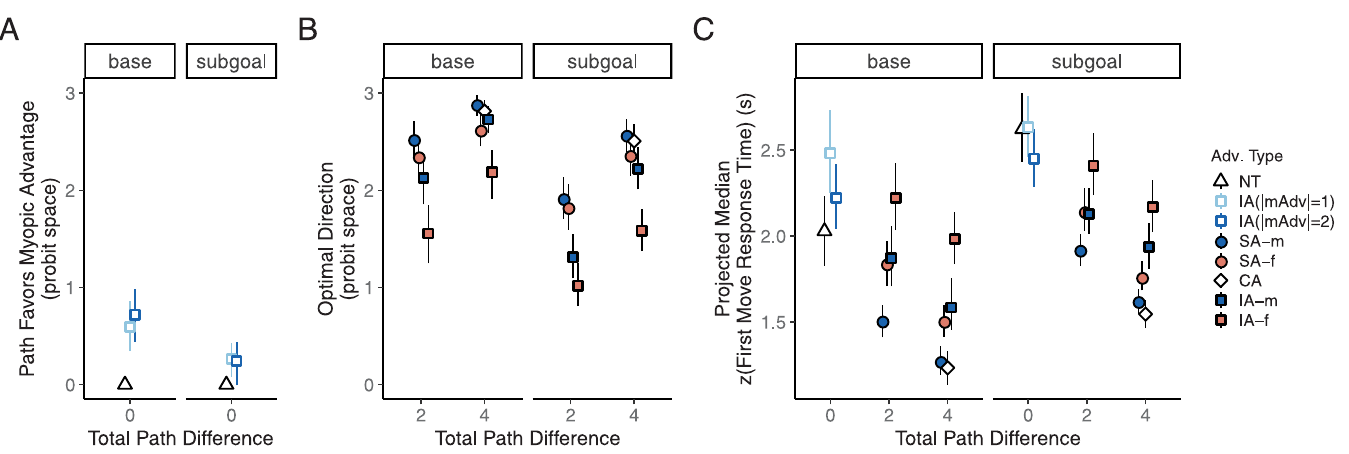
Fig 5. Accuracy and time cost in initial path choices when the two-constraint maze is embedded as a subtask. A. Path selection in the trials with equally optimal initial directions. As in Fig 3A, the value for NT trials was defined to be 0. B. Path selection across advantage pairings in base and subgoal trials. As in Fig 3B, the proportion of optimal trials for each individual was converted into a probit score, with individual probit scores larger than 3 or smaller than -3 capped at 3 or -3 before averaging. C. Response times in the base and subgoal trials. As in Fig 3C, the median zscore response times were projected back to the raw time scale in seconds.